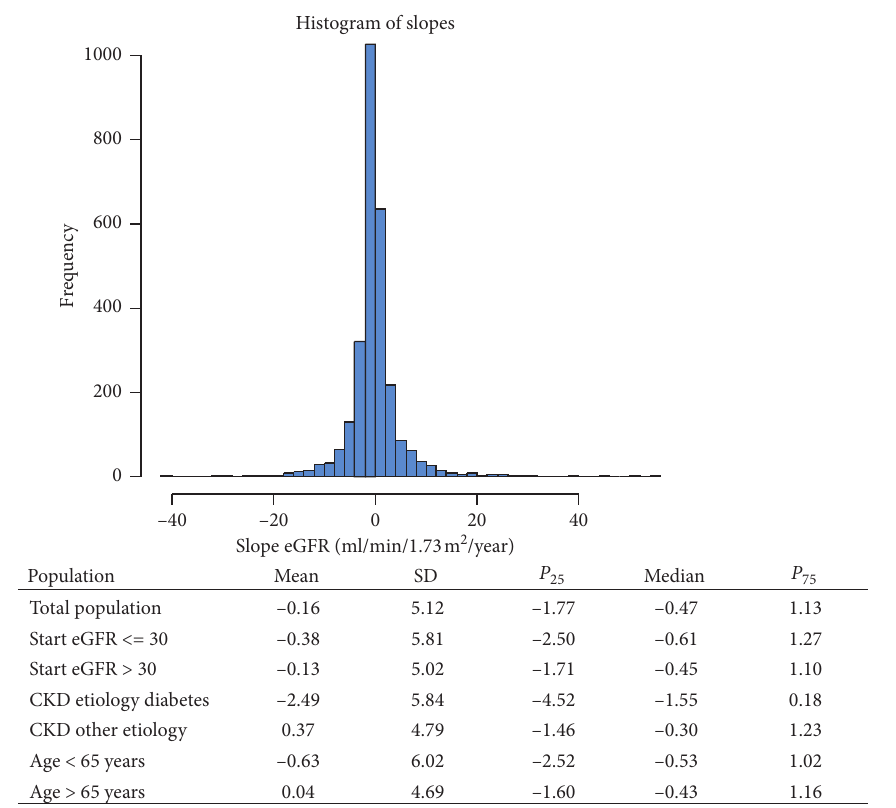
Figure 3: CKD progression. Histogram representing frequency distribution of eGFR slopes in the full